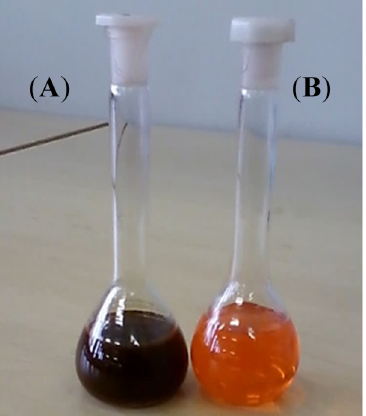
Figure 3. Color of P3HT in chloroform solution ( A ) after formation of nanocomposite and ( B ) pristine P3HT under white light.